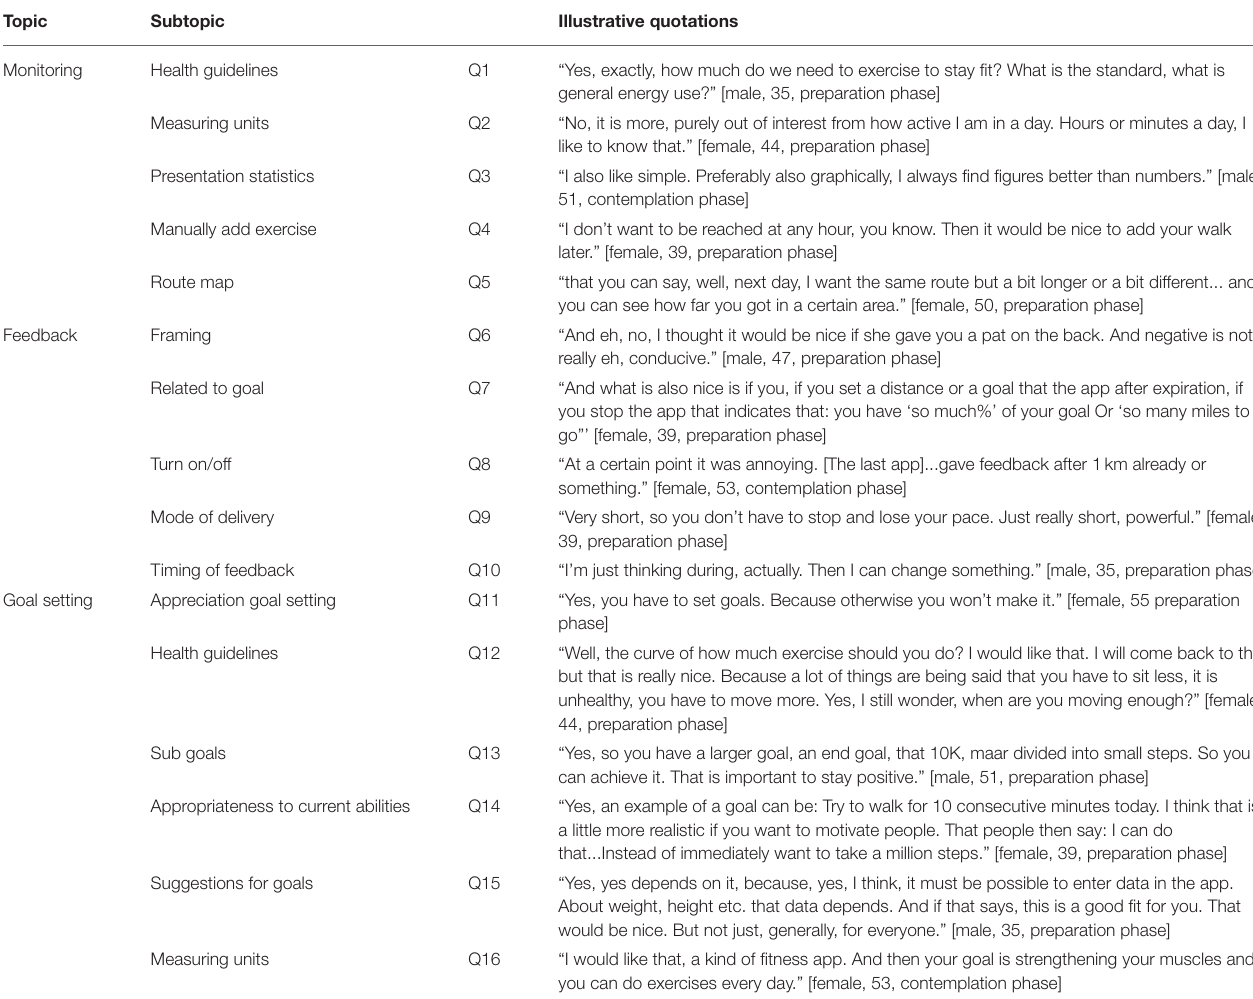
TABLE 4 | Illustrative quotations self-monitoring, feedback, and goal